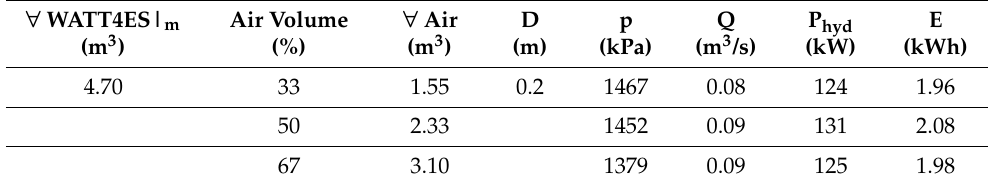
Figure 6. Experiments on energy storage: average pressure for air-volume of 67% in the WATT4ES and for increasing Reynolds number. Table 1. Energy power estimation in the